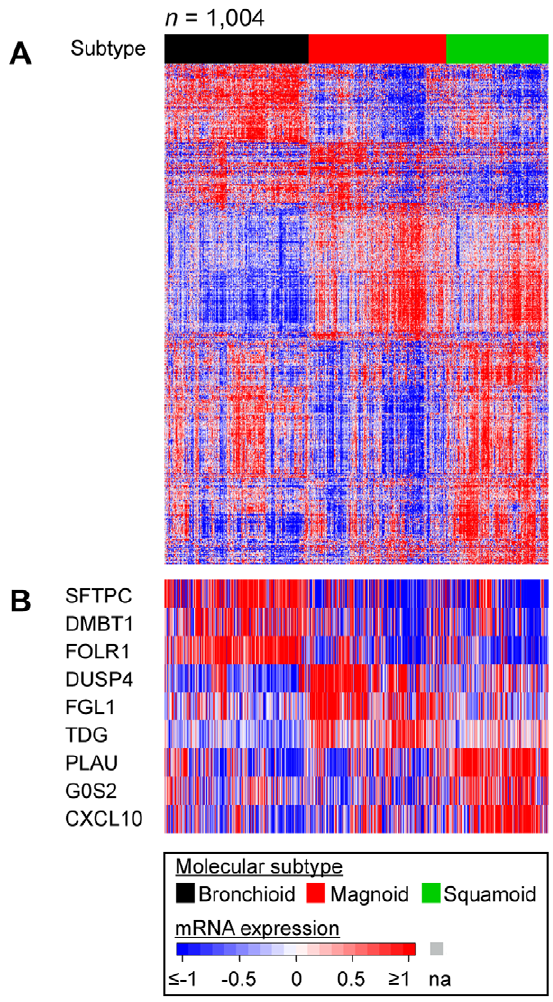
Figure 1. Lung adenocarcinoma molecular subtype expression characteristics. LAD subtype gene expression is displayed for all cohorts (Bhattacharjee et al., Chitale et al., Ding et al., Shedden et al., Tomida et al., UNC, Zhu et al.) in which columns are tumors and rows are genes and shading indicates gene expression level (A). Exemplar genes are displayed separately for visualization ease